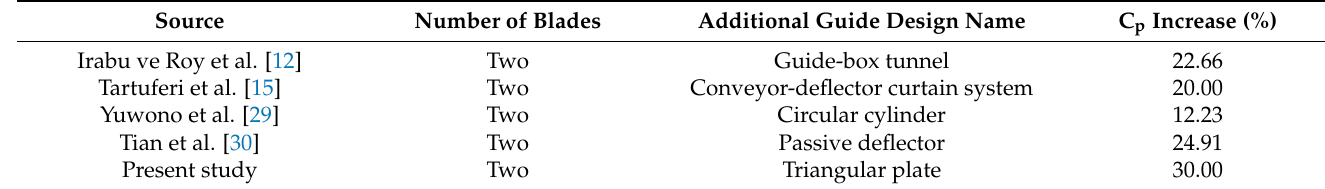
Table 1. Comparison of power coefficient improvement with previous studies.